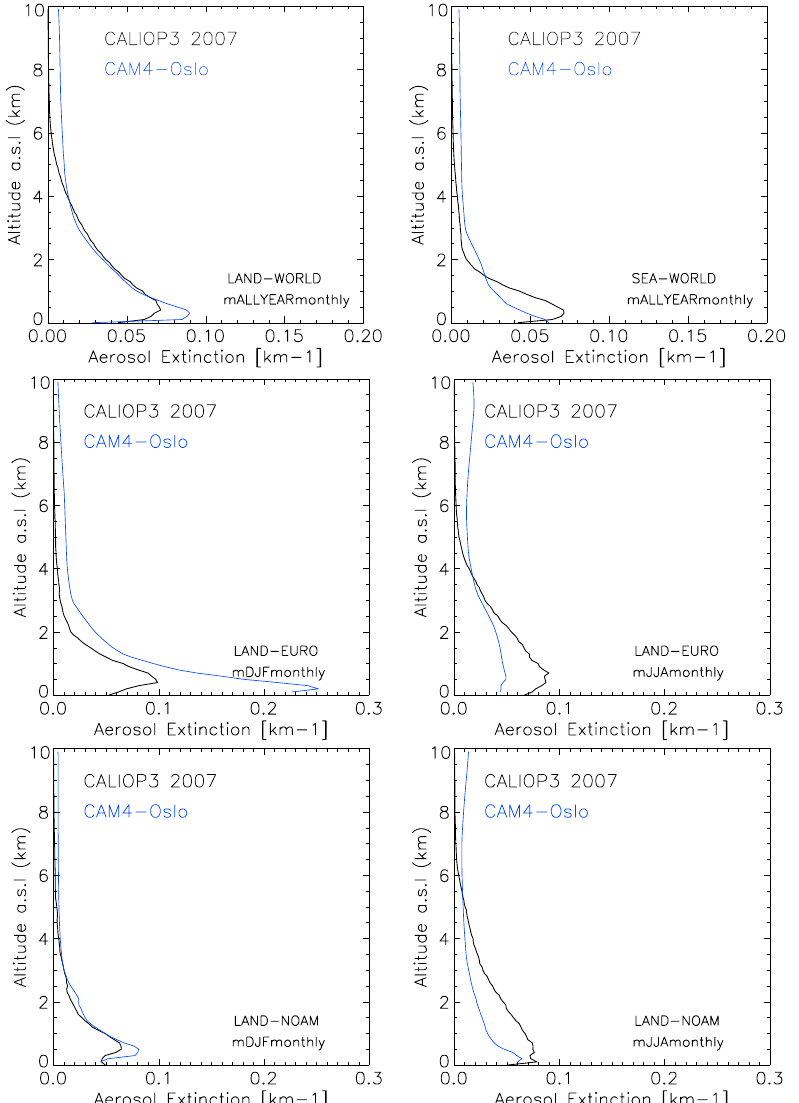
Fig. 10. CAM4-Oslo and CALIOP annually or seasonally averaged extinction coefficient profiles (km − 1 ), continents and oceans globally, and for continental Europe (35–70 ◦ N and 10 ◦ W–40 ◦ E) and North America (25–50 ◦ N and 65–125 ◦ W) for the winter (DJF) and summer (JJA) seasons. The model data are all-sky estimates at 550nm, while the CALIOP data are for 532nm wavelength and for year